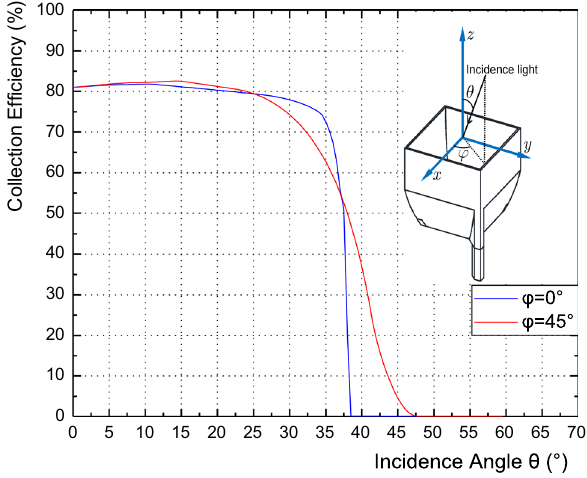
Fig. 8 Collection efficiency for parallel beams of light vs. incidence angle obtained from the ray tracing simulation. The blue and the red lines are the collection efficiencies for the incidence azimuth angle of 0 ◦ and 45 ◦ , respectively. The sub-graph in the upper right corner of the figure shows the definition of the zenith angle θ and the azimuth angle φ